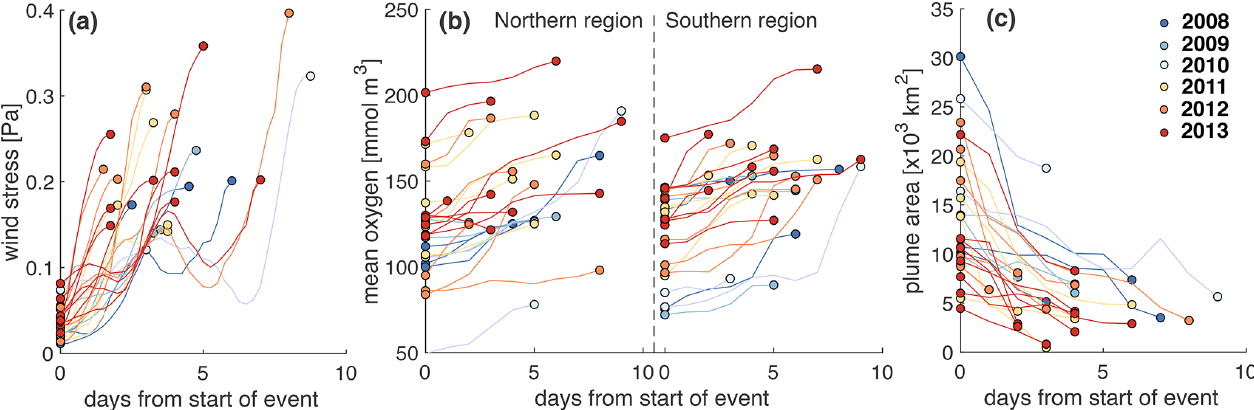
Figure 9. Evolution of (a) wind stress, (b) bottom mean oxygen in the northern and southern regions, and (c) extent of the FW plume during high-wind events. These events are defined by wind stress exceeding 0.12Pa.